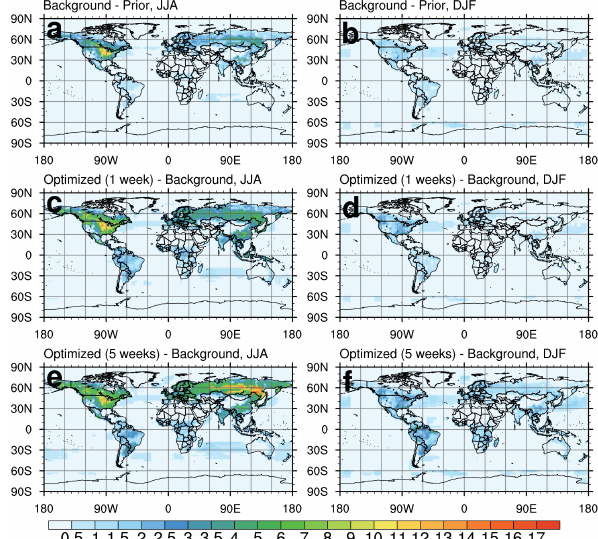
Figure 13. RMSD between the background flux and prior flux in (a) JJA and (b) DJF; RMSD between the background flux and pos- terior flux optimized by 1-week observations in (c) JJA and (d) DJF; and RMSD between the background flux and posterior flux opti- mized by 5 weeks of observations in (e) JJA and (f) DJF. The units are gCm − 2 week − 1